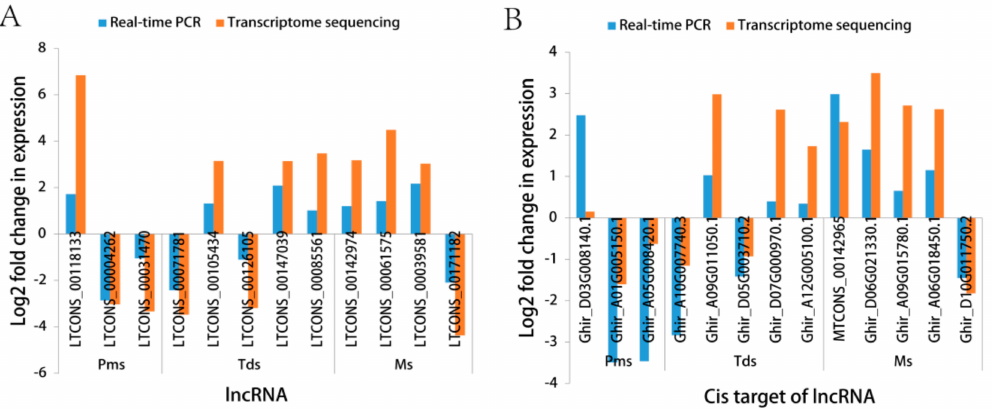
Figure 7. Quantitative PCR (RT-qPCR) confirmation of the RNA-sequencing (RNA-Seq) expression profiles at di ff erent stages of anther development of cotton, between the cytoplasmic male sterility line C2P5A and the maintainer line C2P5B. ( A ) The expression levels of 12 di ff erentially expressed long noncoding RNAs. ( B ) The expression levels of 13 cis -target genes of lncRNAs corresponding to ( A ) lncRNAs, respectively. Of these lncRNAs, LTCONS_00142974 regulated two cis -target genes, MTCONS_00142965, Ghir_D06G021330.1 . GhACT4 -actin was used as a reference gene for